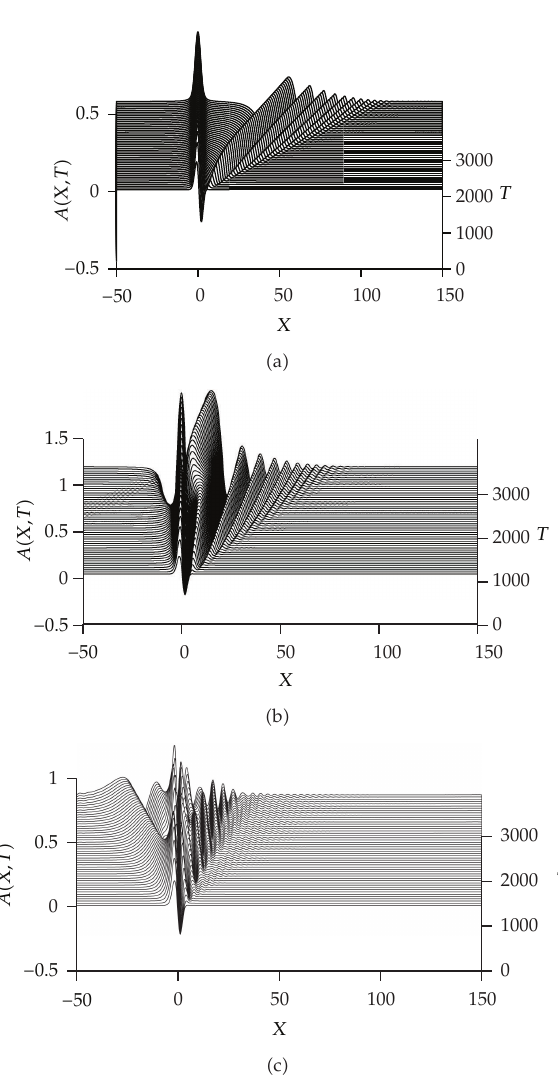
Figure 3: Solitary waves generated by topography in the absent of dissipation, (cid:2) a (cid:3) α (cid:9) 1 . 5 × 10 − 2 ; (cid:2) b (cid:3) α (cid:9) 0; (cid:2) c (cid:3) α (cid:9) − 1 . 5 × 10 − 2